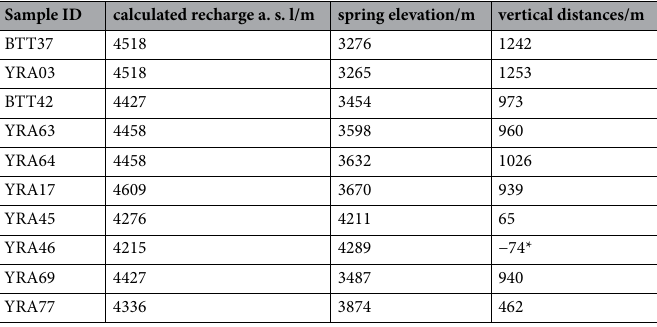
Table 4. Spring elevation and measured data of discharge areas for groundwater samples. *: the negative value is due to the possible fitting deviation in formula (1), and indicates that the altitude difference between the recharge area and discharge area of karst spring numbered YRA46 is not